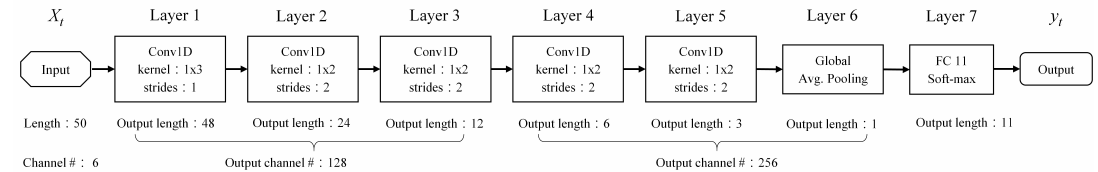
Figure 4. The parameters of the PairNet. The dimension of each sample of X t is 6 ( M = 6). Therefore, there are six channels. Each channel has a length of 50. Layer 1 is a convolution layer with kernel size 1 × 3 and stride size 1. The output length therefore is 48. Layers 2–5 are also convolution layers with kernel size 1 × 2 and stride size 2 for pairing operations. The output lengths of Layers 2–5 are then 24, 12, 6, and 3, respectively. Layer 6 is an average pooling layer averaging three elements to a single one. The number of gestures to be classified is Q = 11. Layer 7 is a fully connected layer producing 11